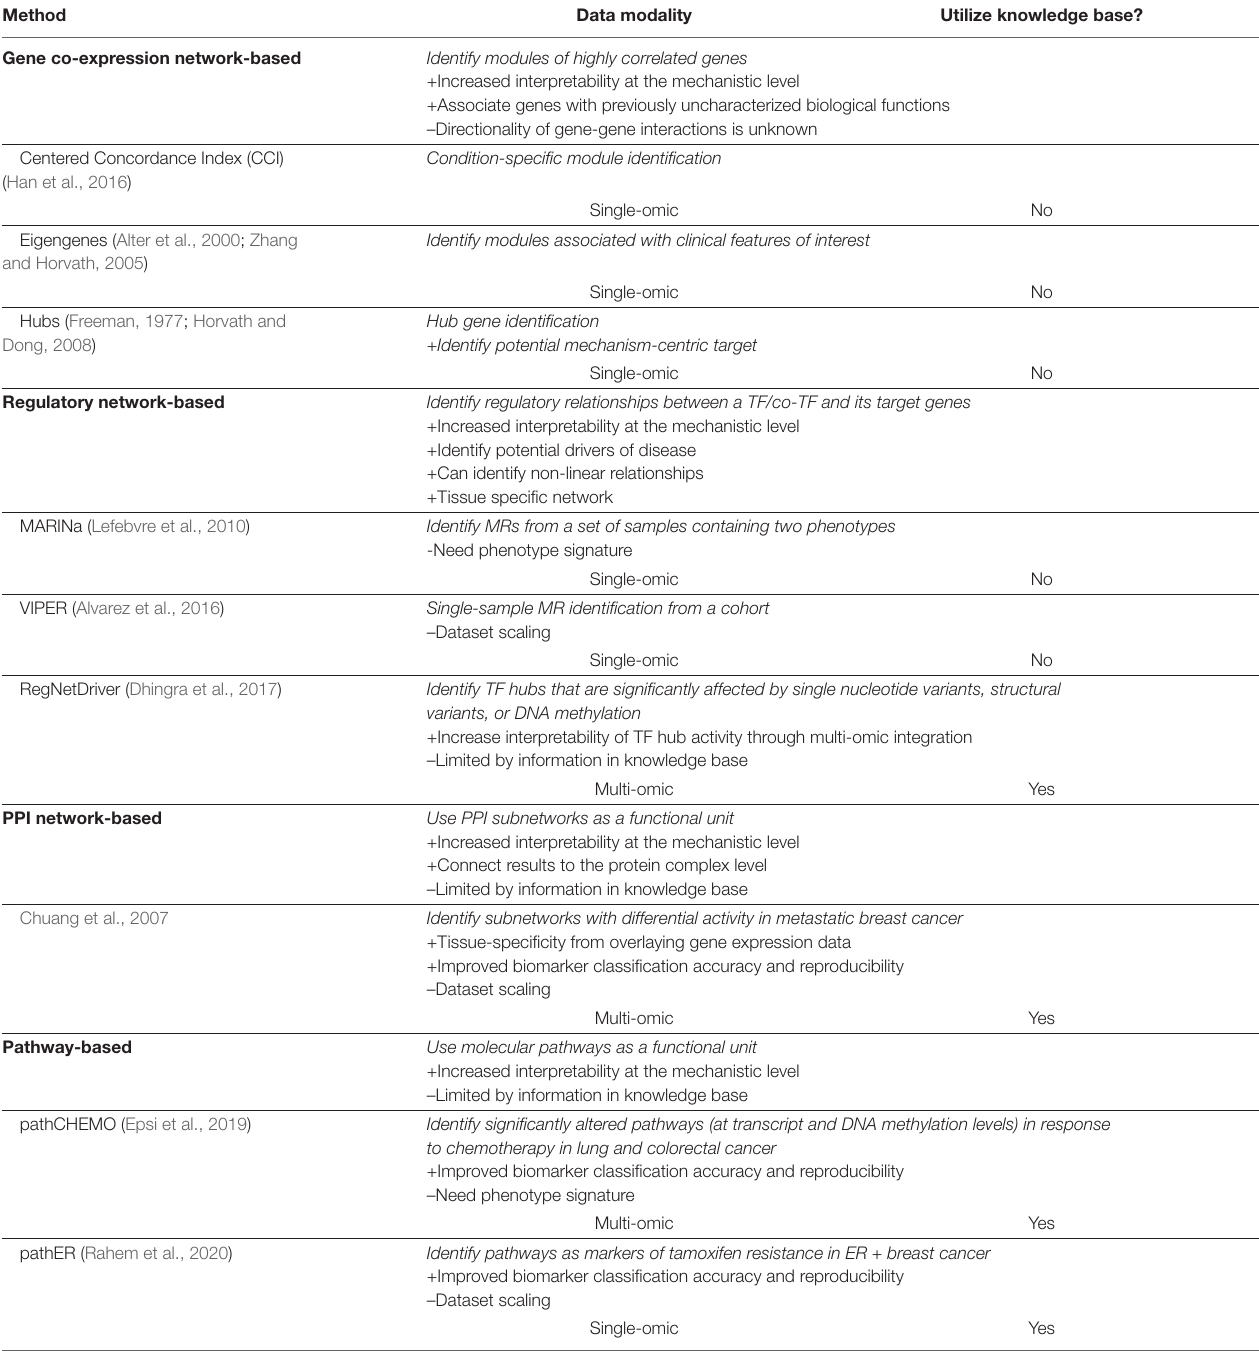
TABLE 1 | Summary of mechanism-centric methods discussed in this